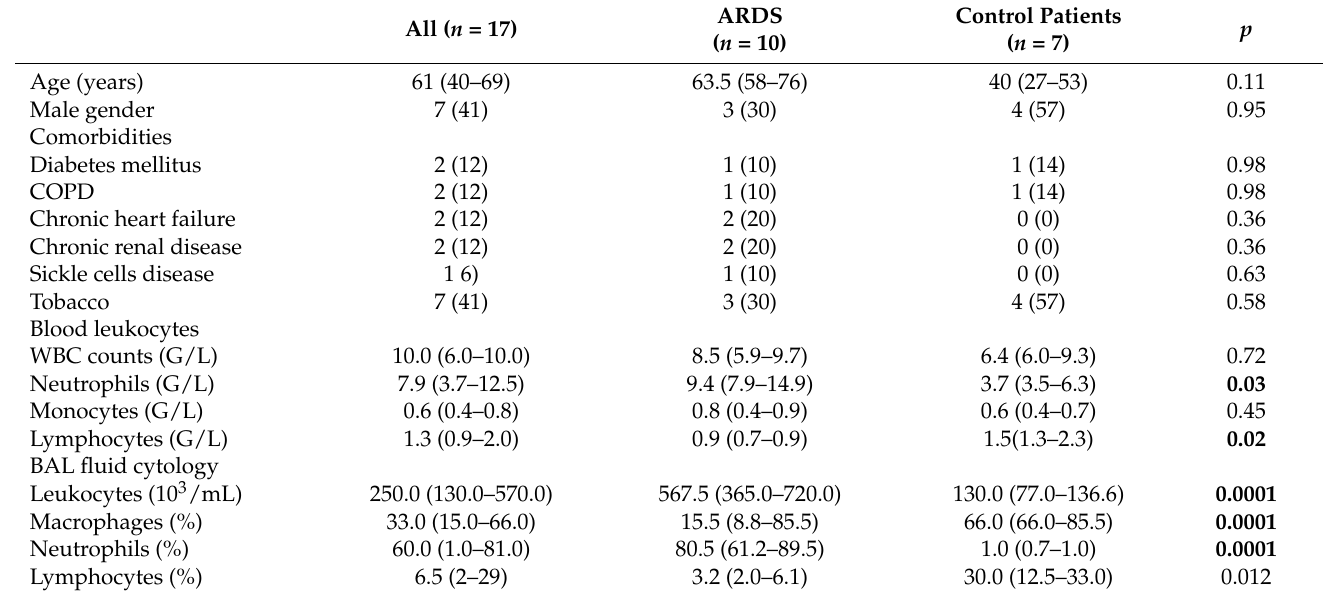
Table 2. Severity and outcomes of patients with pneumonia-associated acute respiratory distress syndrome ( n = 10). * as defined by the Sepsis 3 definition. Continuous variables are presented as median [1st–3rd quartiles]; categorical variables are shown as n (%). ARDS: acute respiratory